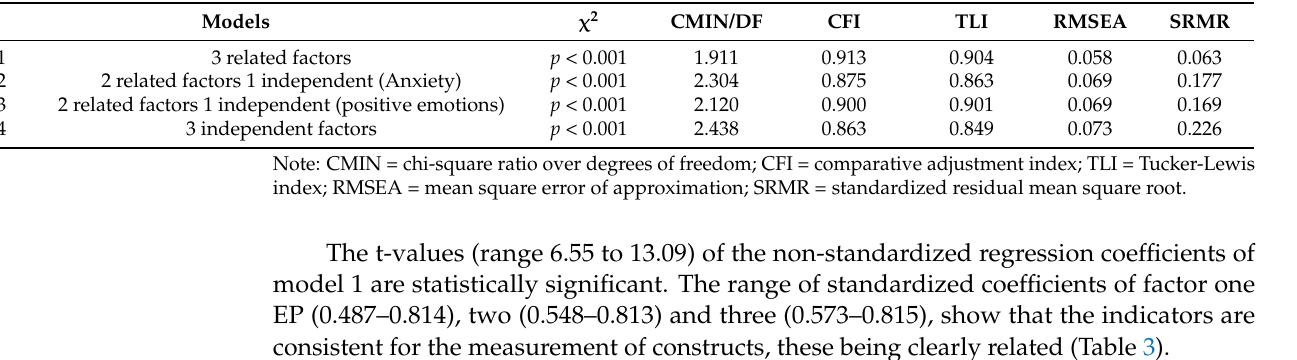
Table 2. Goodness of fit indices of models of emotion in exams